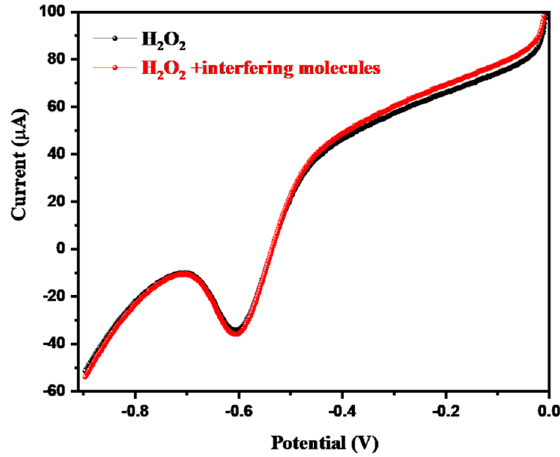
Figure 13. The LSV curves of N-rGO/SPCE in the absence (black) and presence (red) of interfering molecules (glucose, chlorophenol, hydrazine, uric acid, urea, dopamine, ascorbic acid, and nitrophenol) in 0.05 mM H 2 O 2 in 0.1 M PBS of pH 7.0 at a scan rate of 50 mVs − 1 .